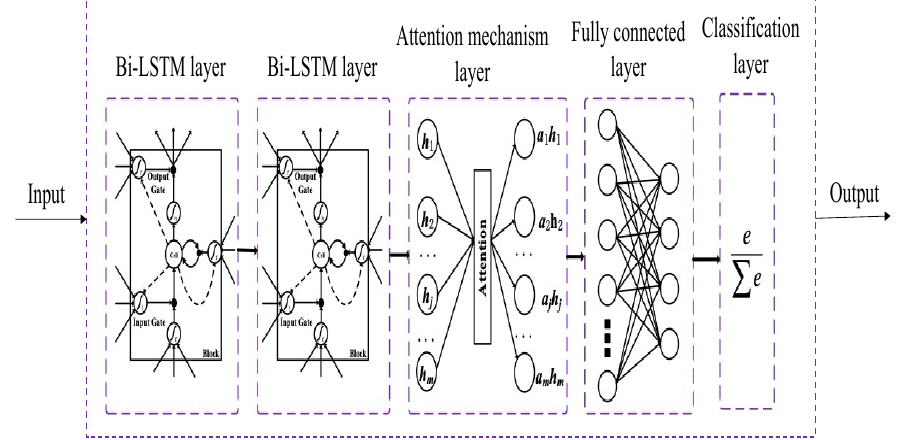
Figure 3. Fault Diagnosis Model Based on